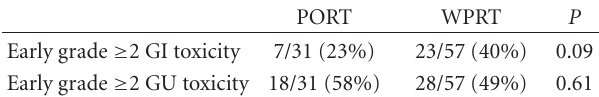
Table 2: Acute toxicity results.